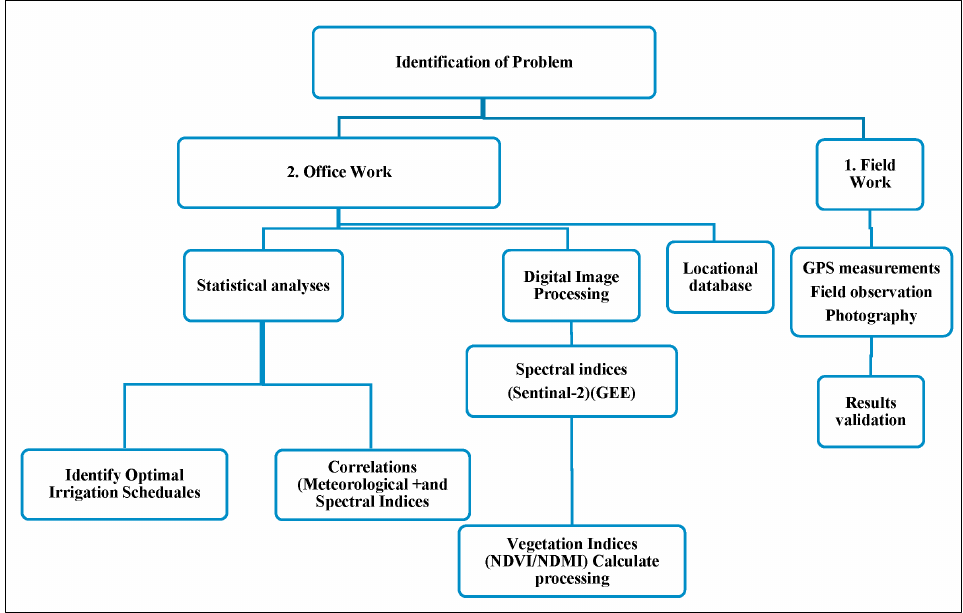
Figure 3. Flowchart of the methodology adopted in this study.